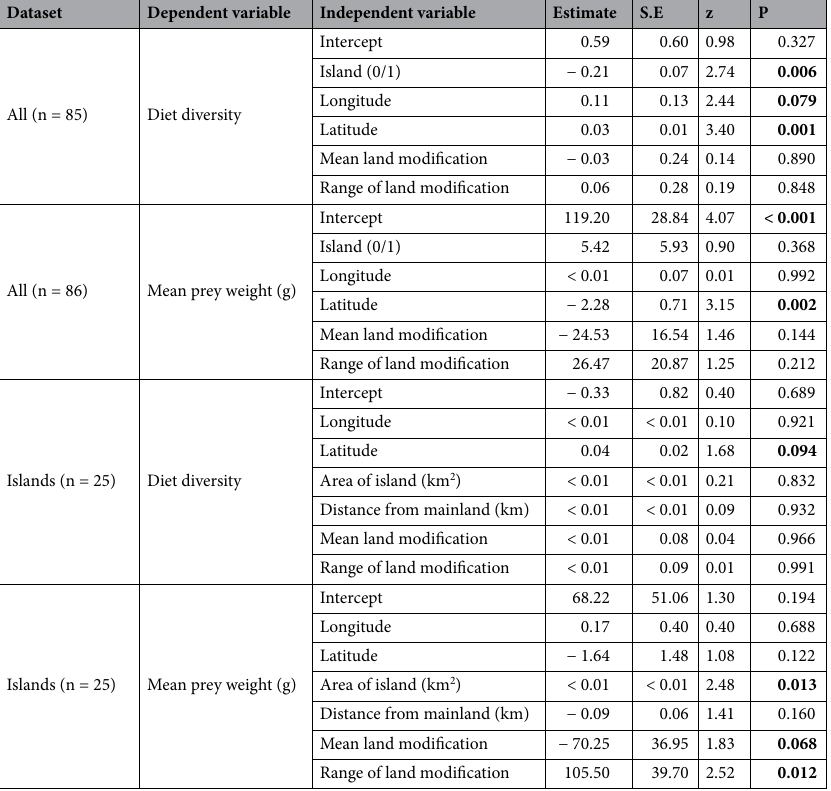
Table 2. The effect of environmental factors on diet diversity index and mean prey weight for the whole Mediterranean region and for islands only, based on multi-model inference. Significant (P < 0.050) or marginally significant (P < 0.100) results are in